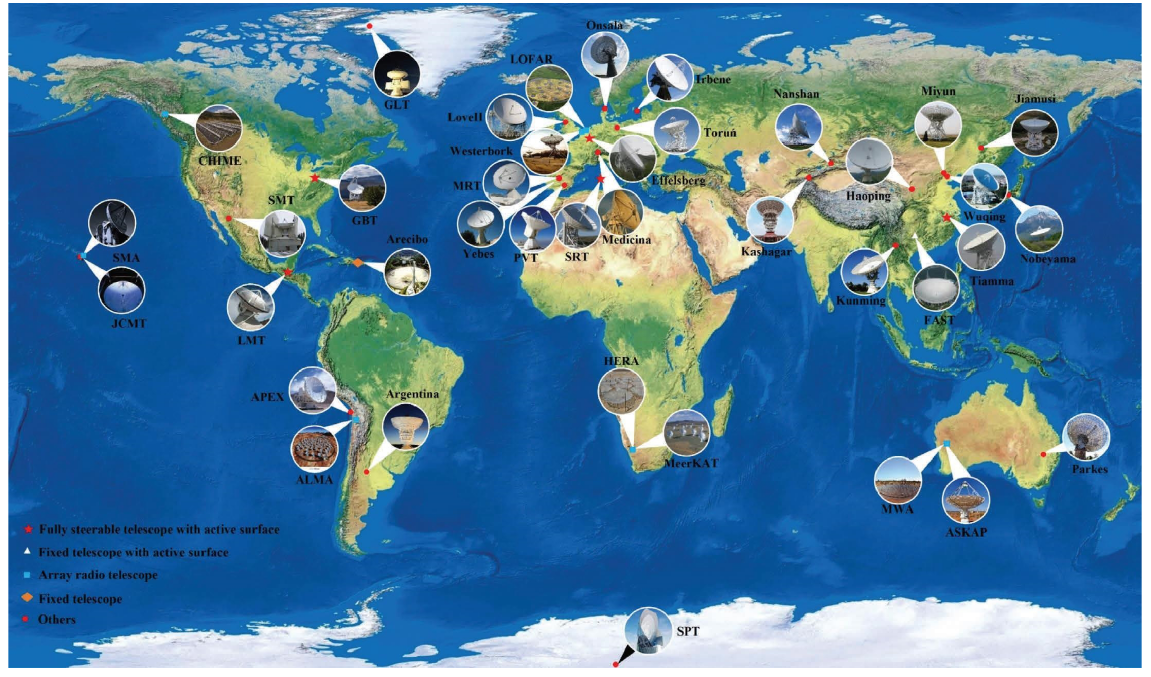
Figure 1: Distribution of radio